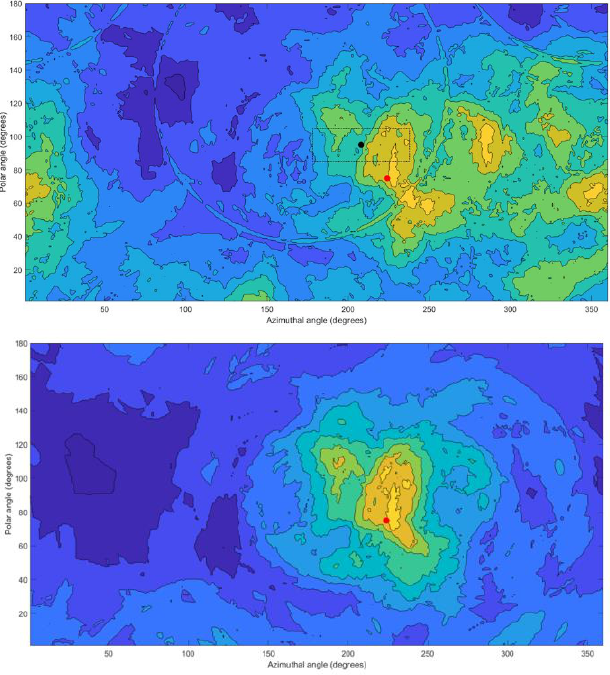
Fig. 11. Raw neutron image of point source 2 measured at source position 2. The image was generated with a first scatter energy deposition cutoff of 0 MeV and a peak prominence ratio cutoff of 2. 42 cones were used to generate the image.